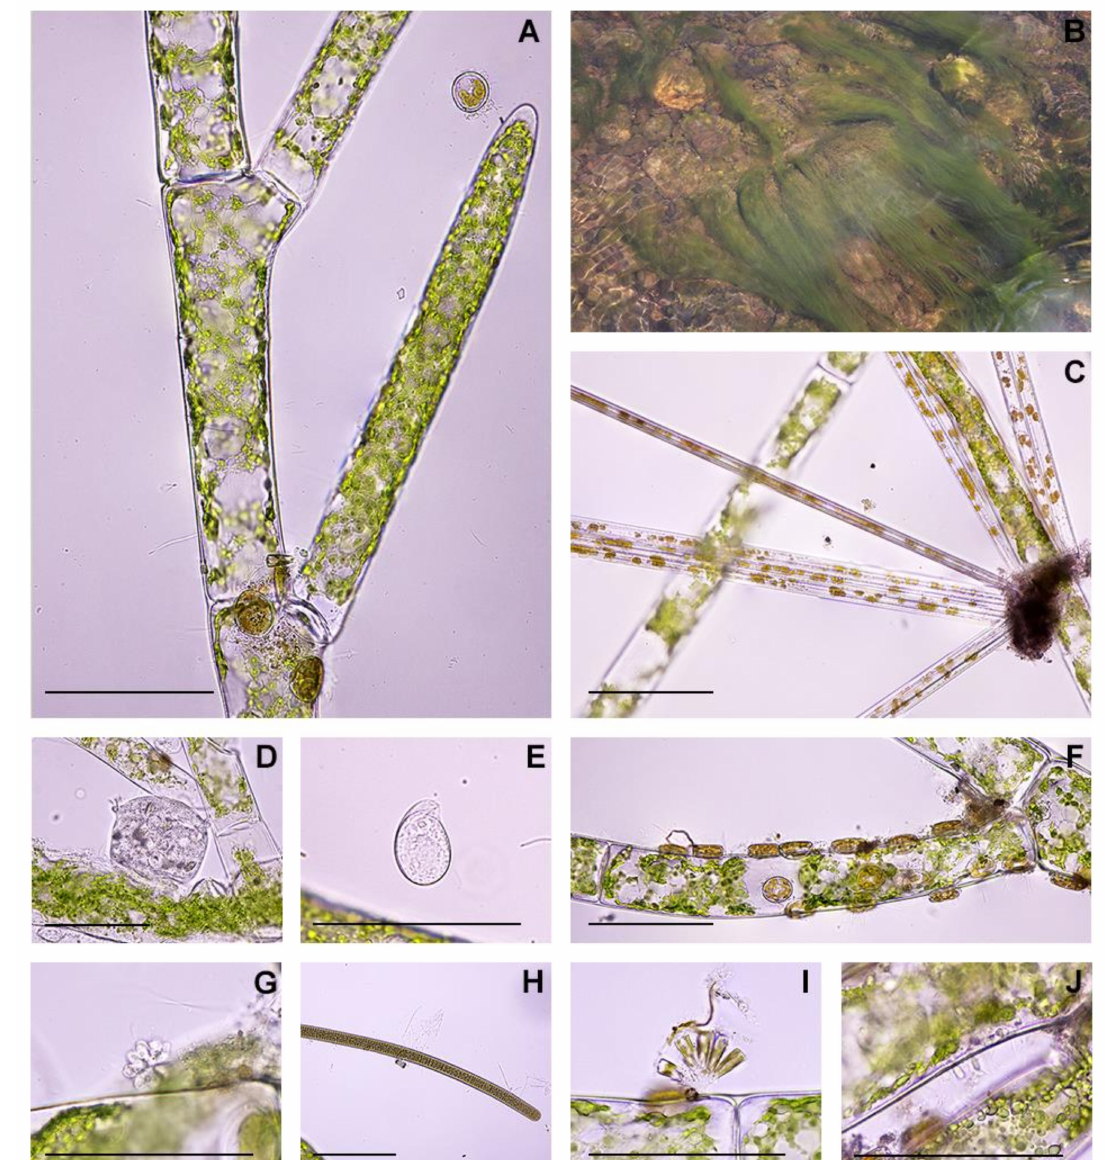
Figure 2. Morphological characteristic of Cladophora sp. collected from Nan River, Thailand, and epiphytic microbes under light microscopy. ( A )—Morphology of Cladophora sp., showing branched monosiphonous filament with reticulate chloroplasts. ( B )—Macroscopic Cladophora sp. filaments attached to substrate. ( C )—Stramenopile Synedra . ( D )—Ciliate Vorticella . ( E )—other Ciliate. ( F )—Stramenopile Cocconeis . ( G )—Stramenopile Synura . ( H )—Cyanobacterium Oscillatoria . ( I )—Stramenopile Gomphonema . ( J )—Cyanobacterium Chamaesiphon . Black scale bars: 100 µ